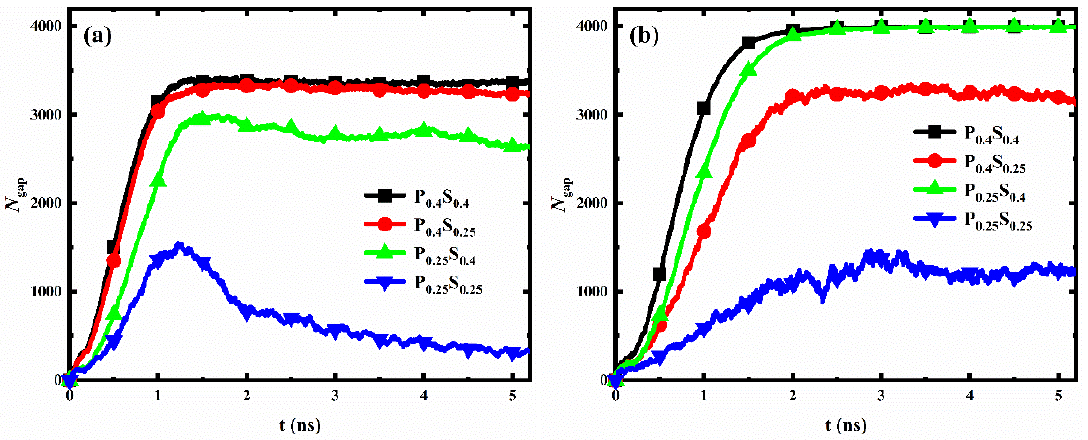
Figure 11. The evolution of the number of water molecules in the gaps between nanopillars for different nanopillar surfaces. The interpillar spacing of the surface is ( a ) D 2 ; ( b ) D 3 .